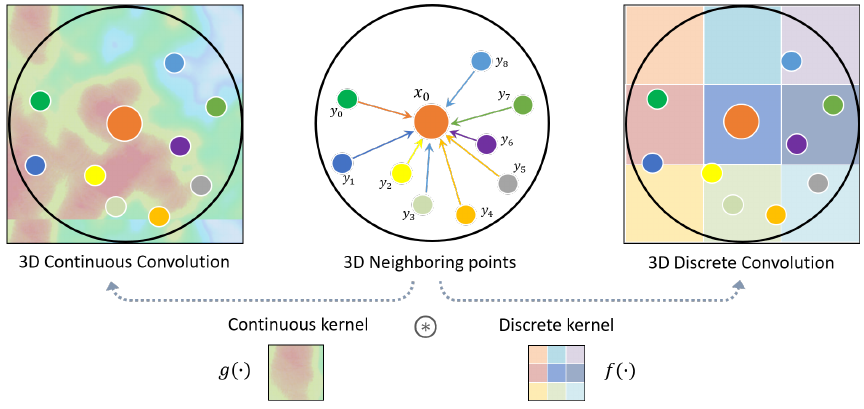
Figure 8. Different types of point convolution